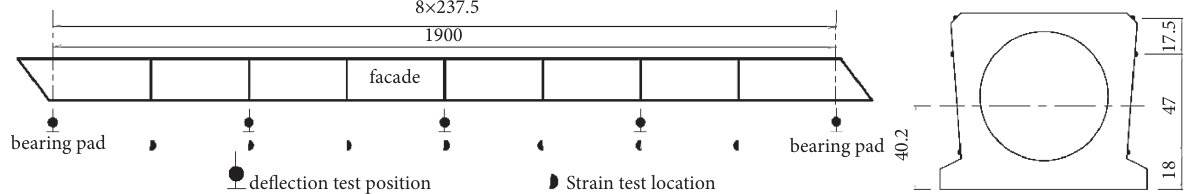
Figure 6: The strain location and deflection measuring